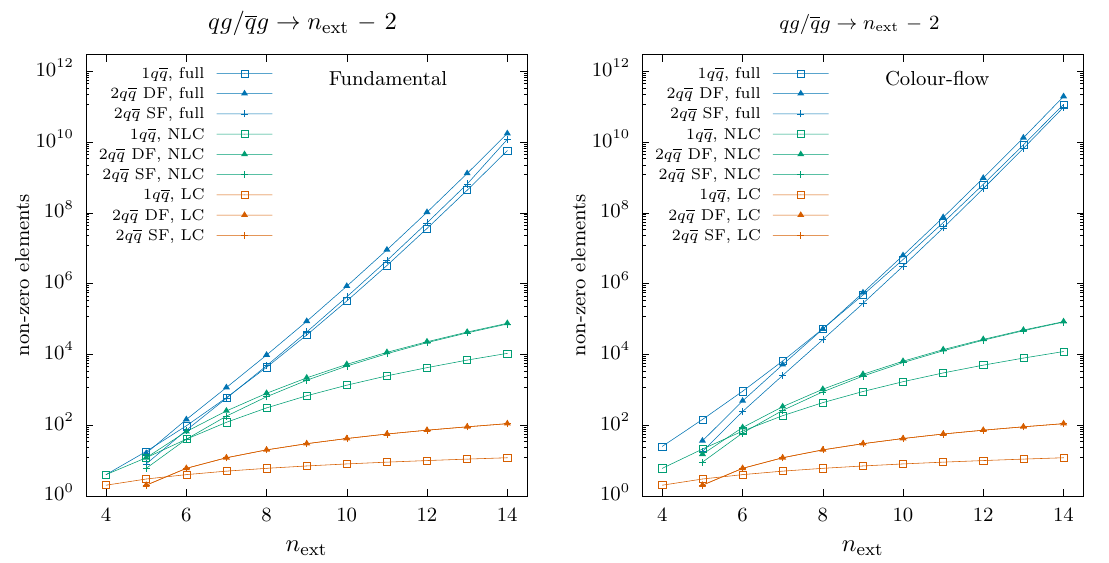
Figure 3 . Number of non-zero elements in the colour matrix at LC (red), NLC (green) and full colour (blue) for qg/qg initial state in fundamental (left) and colour-flow decomposition (right) for various channels: one-quark-pair (box), two-quark-pair distinct-flavour (triangle) two-quark-pair same-flavour (bar).